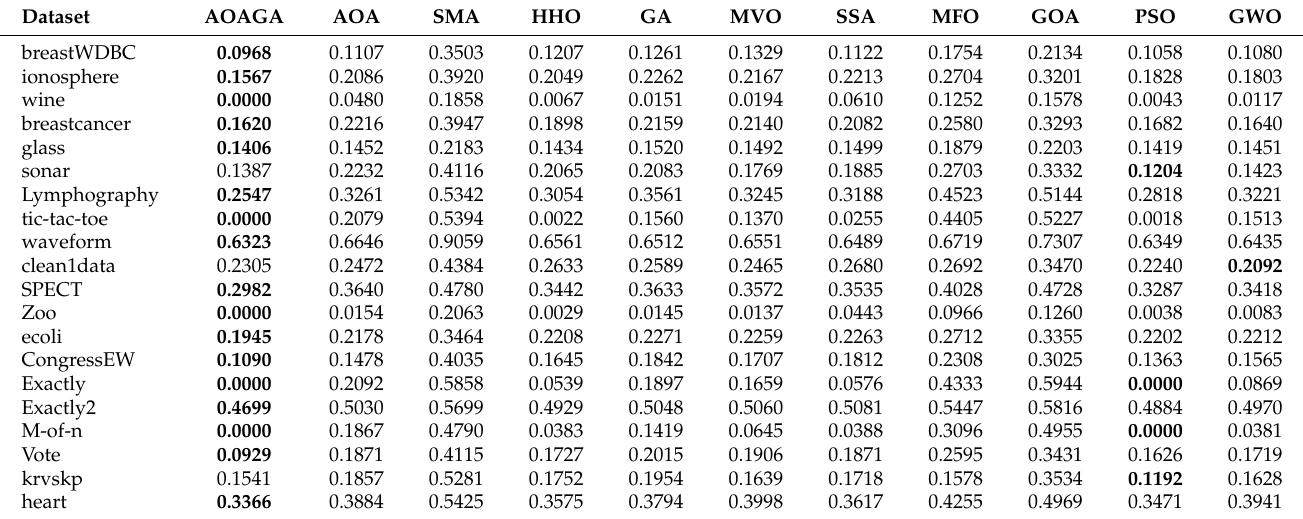
Table 2. Results of the Fitness values for all